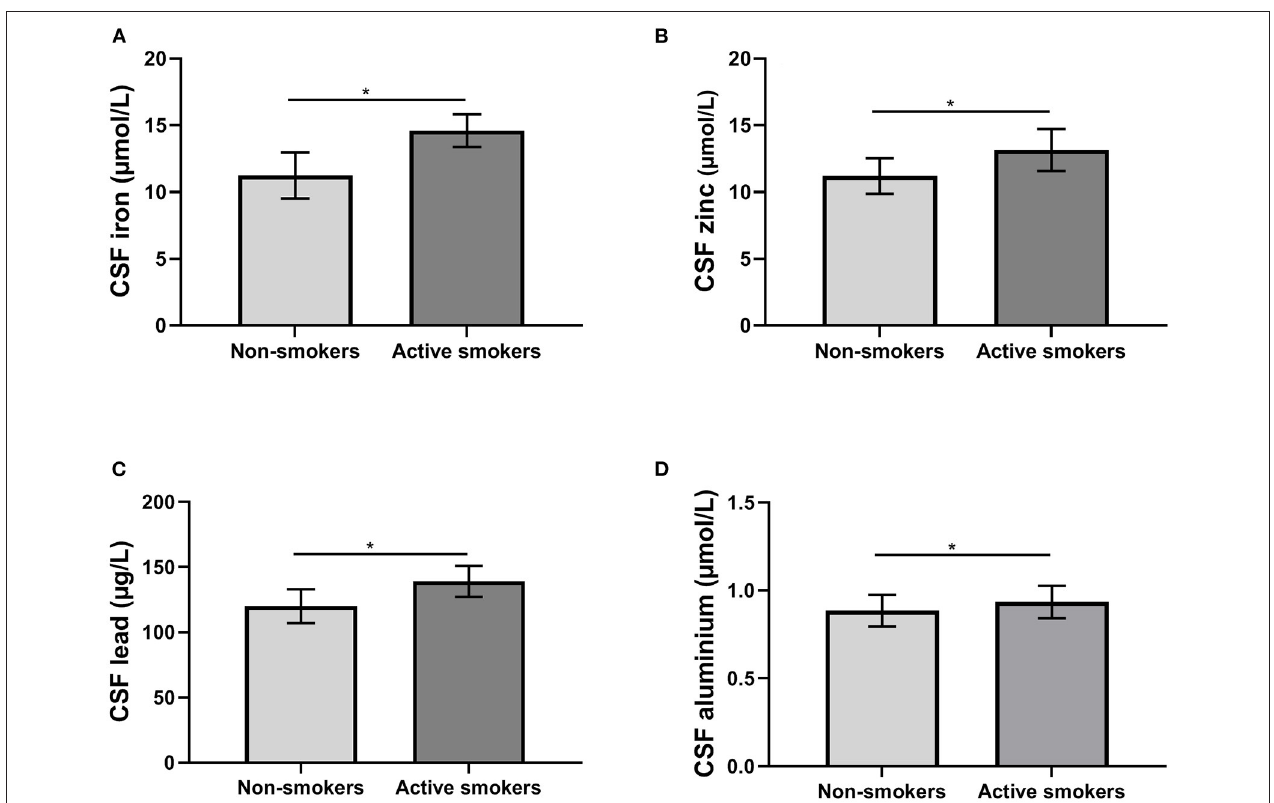
FIGURE 1 | The differences of biomarkers in cerebral spinal fluid (CSF) between groups. (A) The differences of iron levels; (B) the differences of zinc levels; (C) the differences of lead levels; (D) the differences of aluminum levels. * p < 0.05.